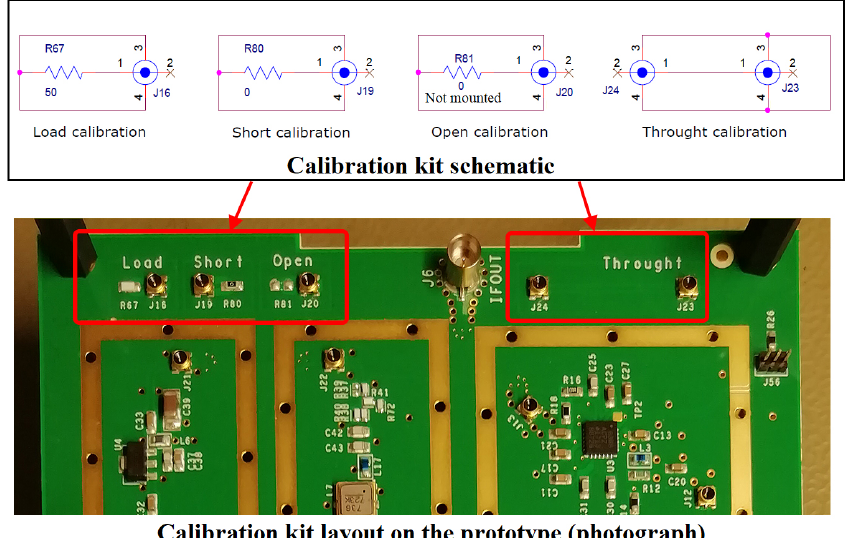
Figure 4. Custom calibration kit for the mate-connector of the RF test points. Top image shows the schematic and bottom image shows a photograph of the its implementation on the prototype board.